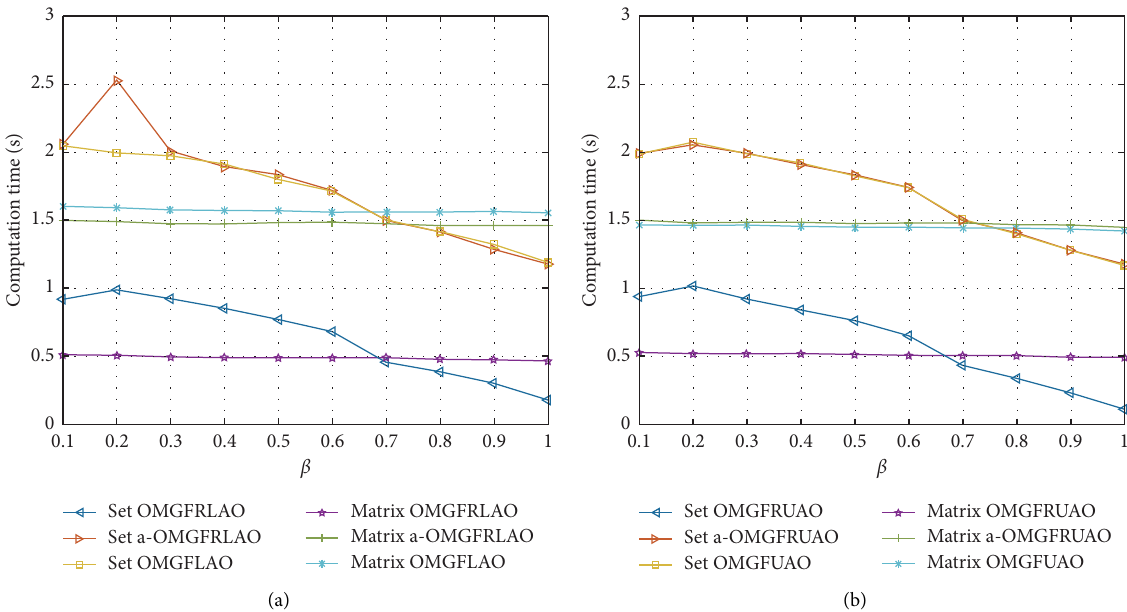
Figure 1: Computational time of matrix methods and set methods with diferent β (| U | � 500 , | 􏽢 C | � 500 ) . (a) Comparison of matrix methods and set methods of lower approximation operators with diferent β . (b) Comparison of matrix methods and set methods of upper approximation operators with diferent β .